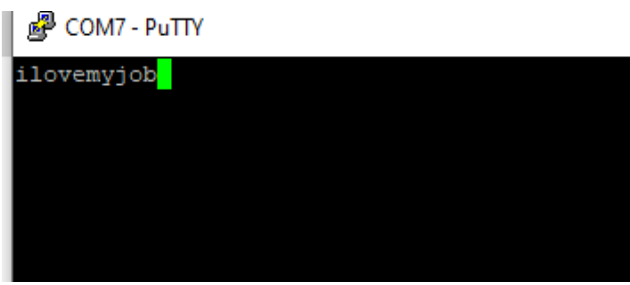
Figure 20. Text Characters successfully received at the UART reception port.